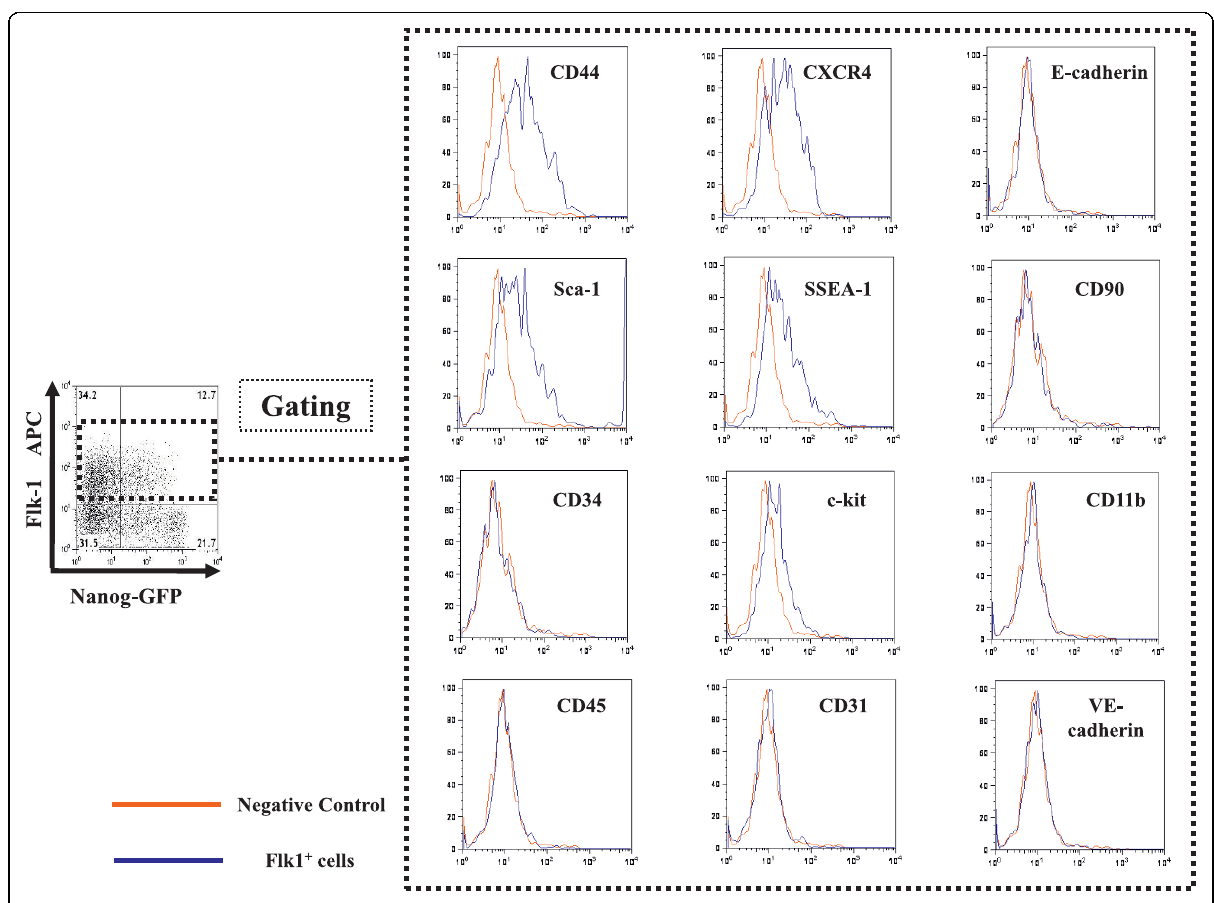
Figure 2 Characterization of Flk1+ cells . Differentiated iPS cells were analyzed by FACS. Differentiated iPS cells were stained with Flk1-APC and additional cell marker (c-kit, Sca-1, CD11b, CD31, VECAD, CD34, CD44, CD45, CD90, SSEA-1, CXCR4 and ECAD). Additional cell marker was analyzed after gating Flk1 + cells. Red line shows the result of the negative control and Blue line shows the result of the sample stained by each